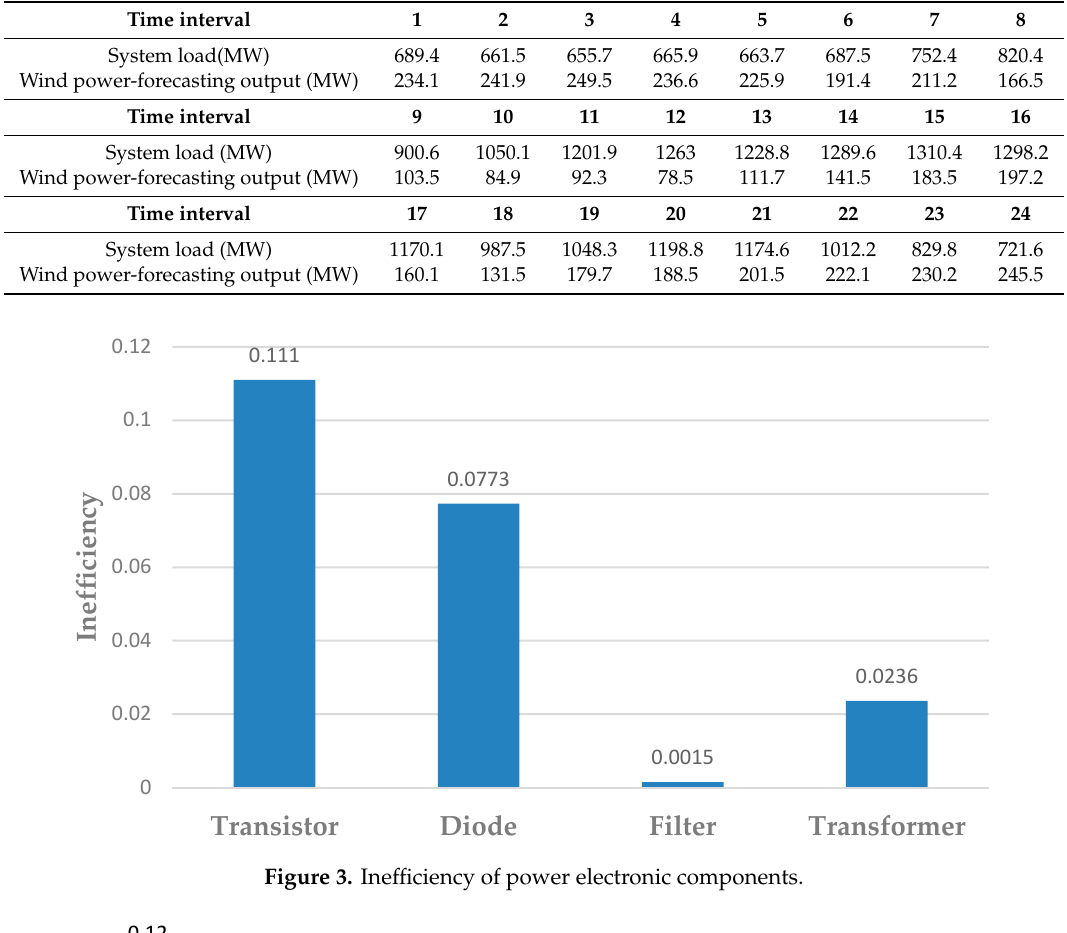
Table 2. Data of the system load and the wind power-forecasting output.